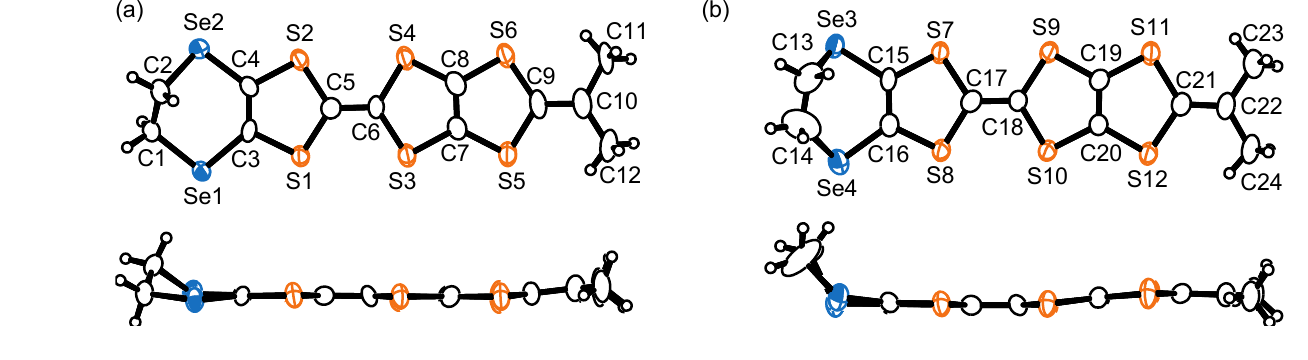
Figure 13. Top view and side view of ORTEP drawings of ( a ) Molecule A and ( b ) Molecule B of MeDTES in 6 . Displacement ellipsoids are drawn at the 50% probability